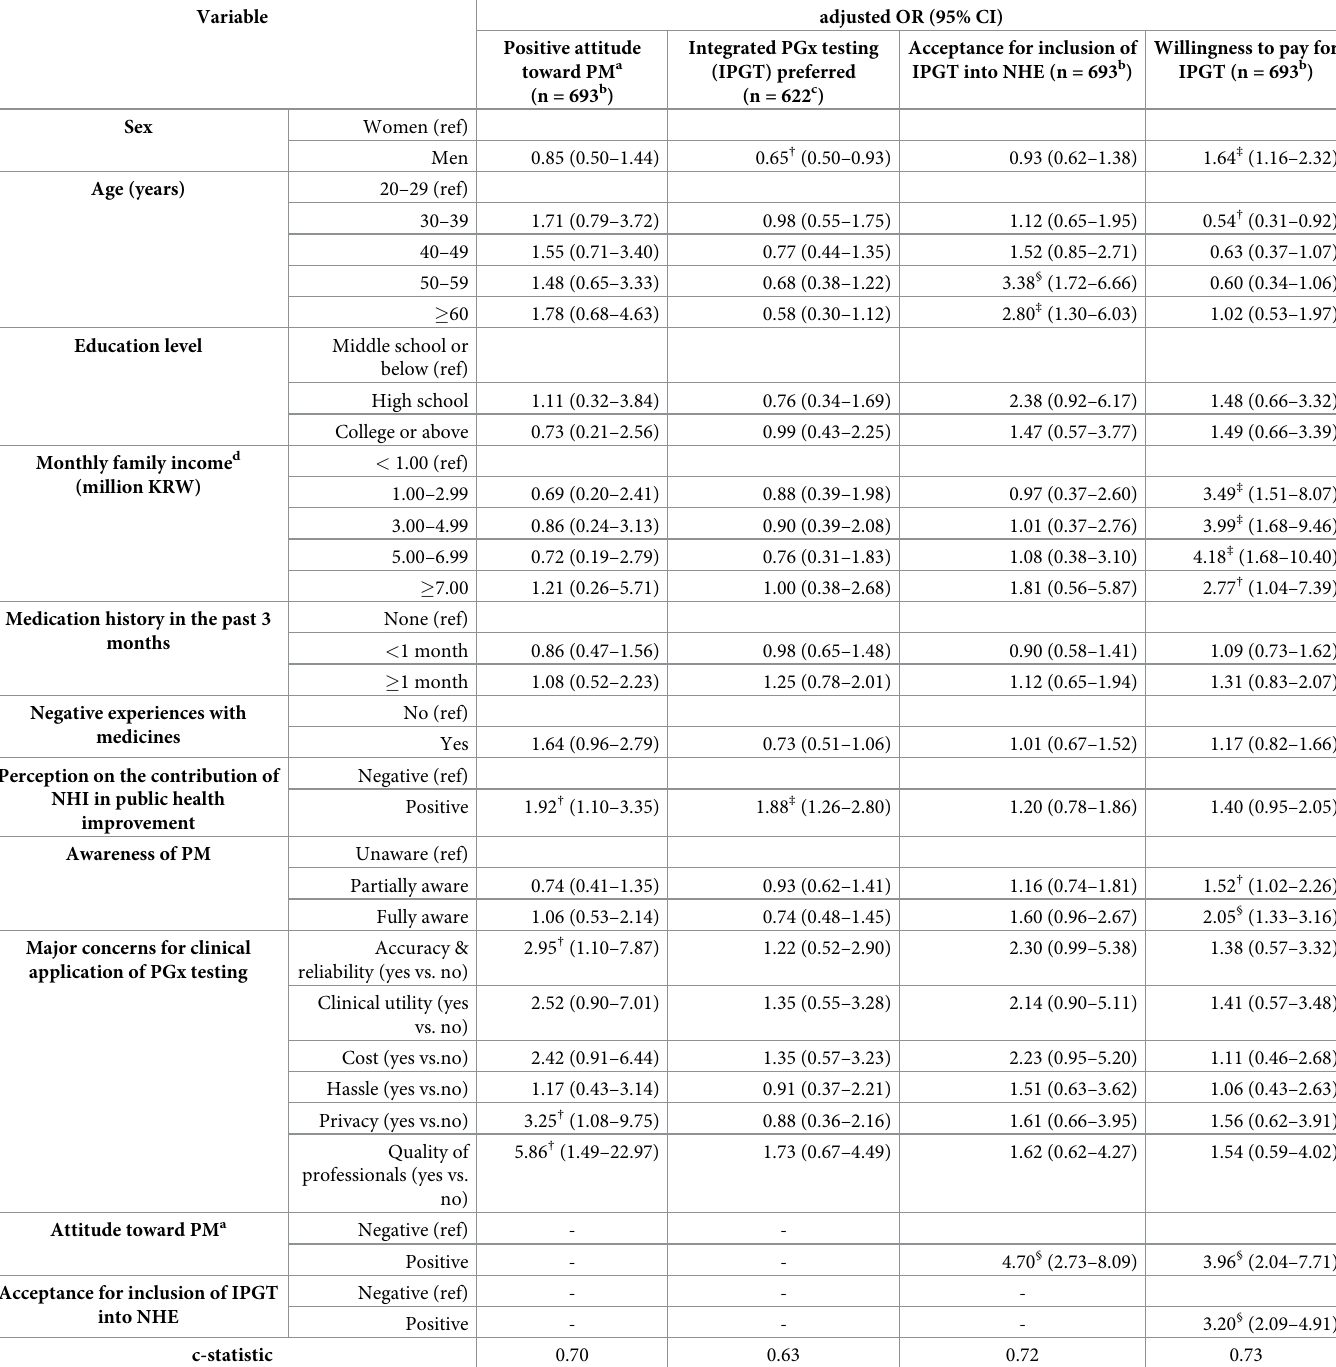
Table 4. Multivariate logistic regression analysis results for factors that are associated with public attitude toward personalized medicine in